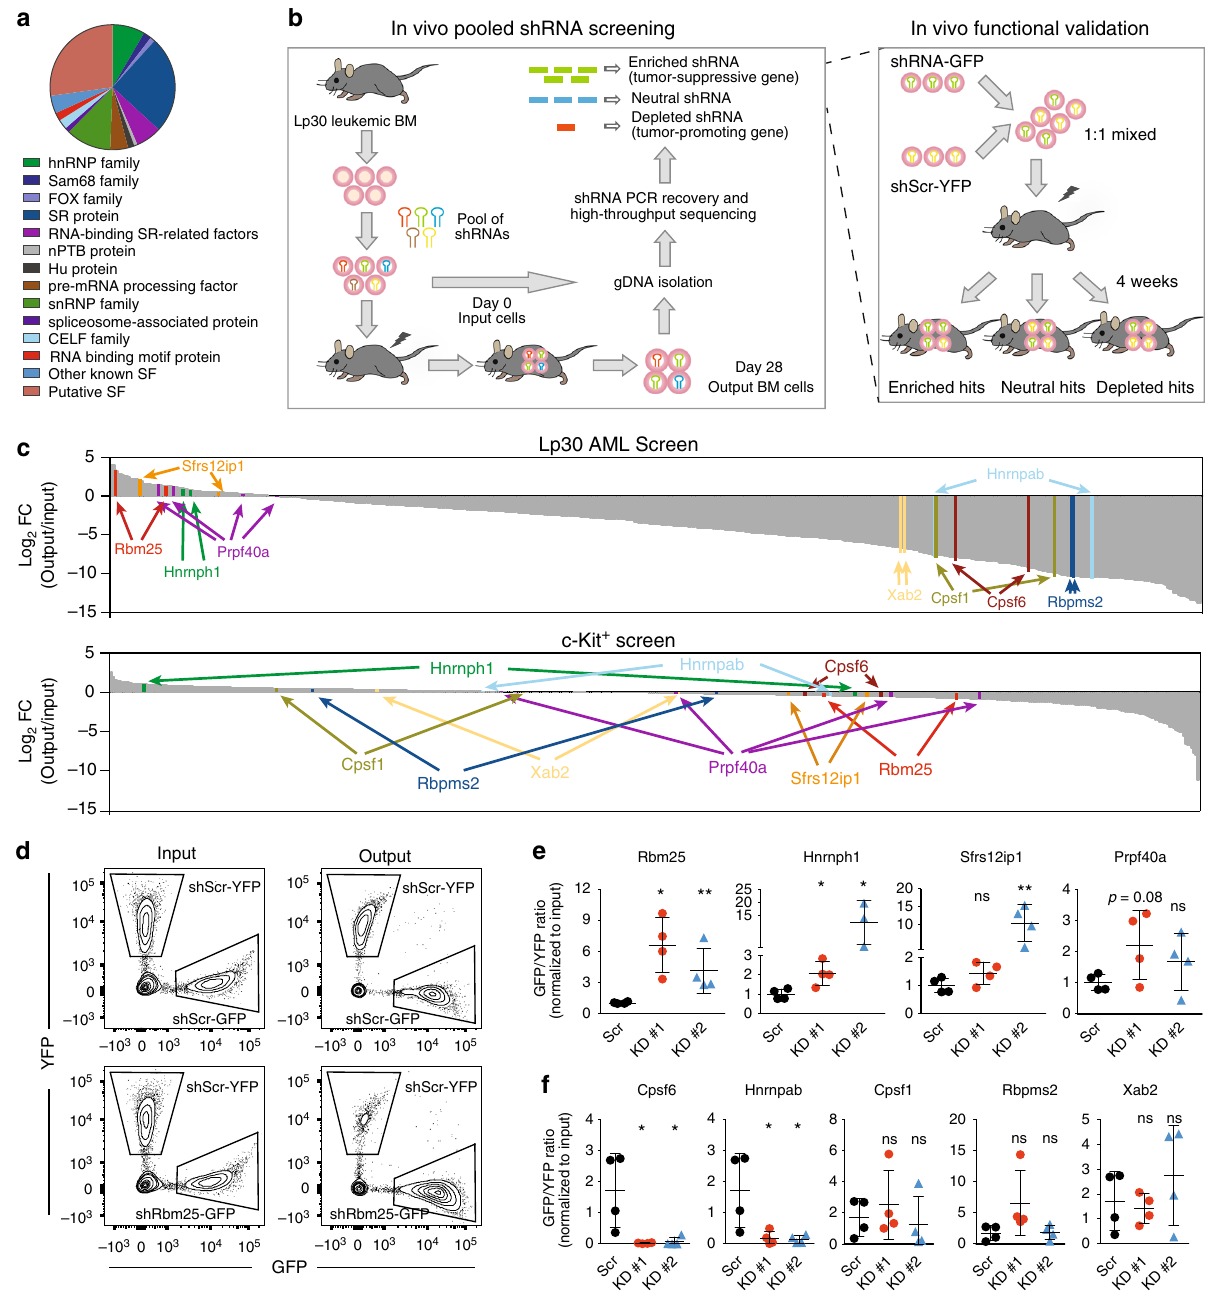
Fig. 1 Pooled in vivo shRNA screen for essential splicing factors in the Lp30 AML model. a Relative proportions of splicing factor categories represented in the shRNA library. b Schematic outline of the in vivo shRNA screen (left panel) and the in vivo GFP/YFP competitive assay used to functionally validate candidates (right panel). In the screening procedure, sublethally irradiated recipients were transplanted with library-transduced Lp30 AML cells and allowed to develop AML, after which the relative representation of the individual shRNA inserts in output vs. input cells was assessed. For validation, cells transduced with candidate-speci fi c shRNA/GFP and scrambled shRNA/YFP-expressing retrovirus were mixed and injected into recipients who developed AML, after which GFP/YFP ratios in output vs. input cells were quanti fi ed by fl ow cytometry. c Results of screens carried out in Lp30 AML cells (upper panel) and normal c-Kit + cells (lower panel). The log 2 fold changes in the representation of individual shRNAs in output vs. input samples are indicated. shRNAs targeting selected candidate genes are highlighted. d Representative example of GFP + and YFP + cells in input vs. output AML cells from the in vivo validation of Rbm25 . e , f In vivo validation of candidate shRNAs, which were either enriched ( e ) or depleted ( f ) in the Lp30 screen ( c ). Data represent the mean ± s.d. ( n = 4 for each group). Data were subjected to an unpaired t test, and asterisks indicate the following: * P < 0.05; ** P < 0.01. Panel ( e ) shows representative results of two independent experiments for Rbm25 . All replicates in e and f are biological replicates transplantations (BMT) using Lp30 donor cells transduced with Fig. 1e). In this assay, KD of Rbm25 and Hnrnph1 gave rise to target-speci fi c shRNA constructs coexpressing GFP along with signi fi cant enrichment of cells transduced with either of the two YFP-expressing nontargeting (scrambled) shRNA-transduced target-speci fi c shRNAs over their scrambled shRNA-transduced competitors (Fig. 1d, see KD ef fi ciencies in Supplementary counterparts (Fig. 1e), thus recapitulating the phenotype from the NATURE COMMUNICATIONS| (2019) 10:172